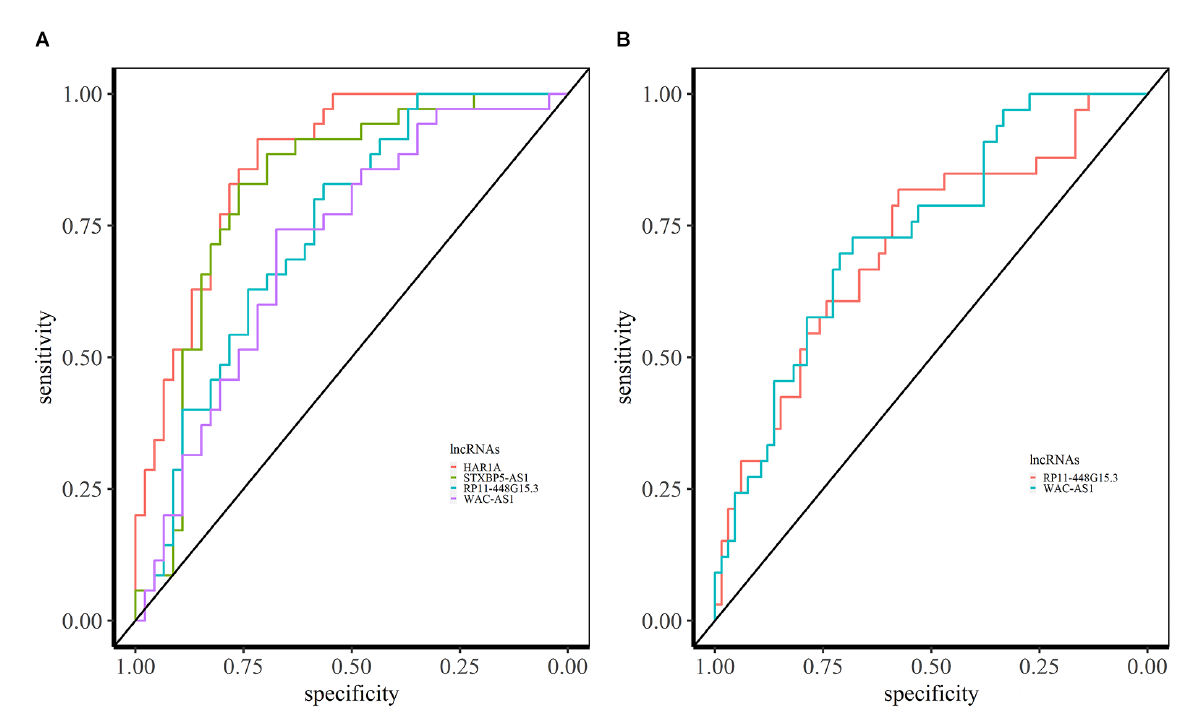
FIGURE6 ROC analysis based on lncRNA expression in ASD. (A) ROC curves of HAR1A, STXBP5-AS1, RP11-448G15.3, and WAC-AS1 in syn11242290 (ASD—pancortical). (B) ROC curved of RP11-448G15.3 and WAC-AS1 with AUC > 0.70 in PBMC.